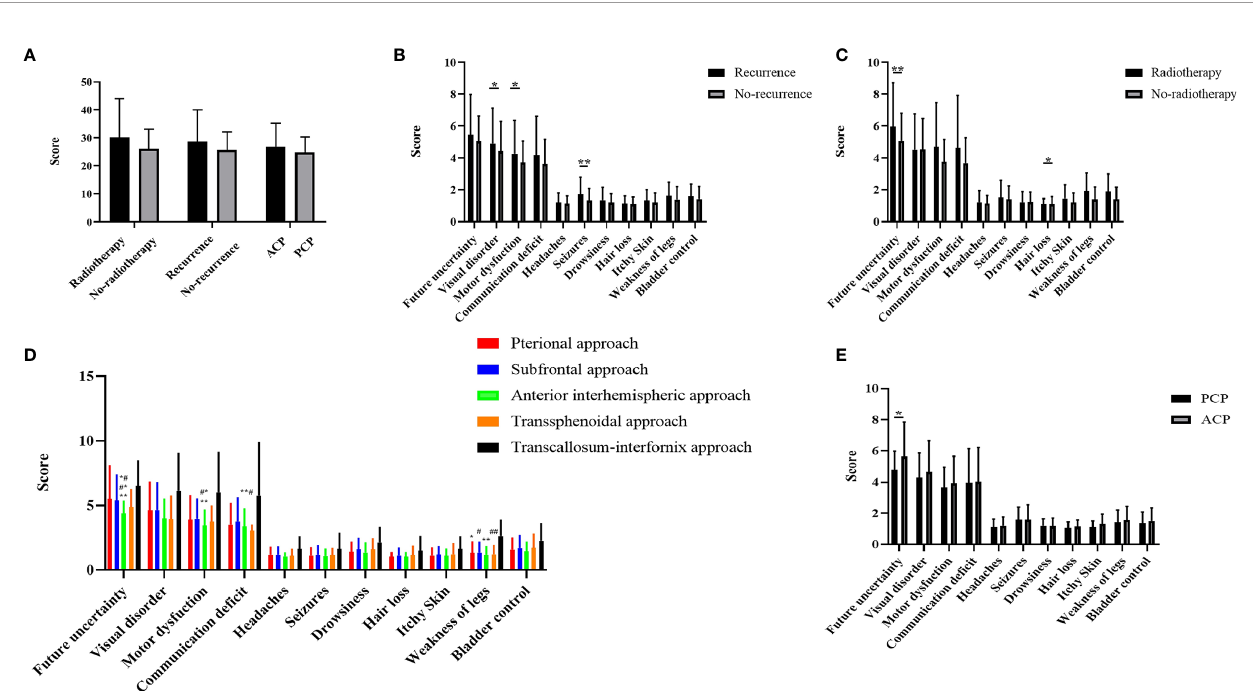
FIGURE 4 | (A) Comparison of three groups of variables on the total BN20 score (Mann-Whitney U test, *p < 0.05, **p < 0.01). (B) Comparison of craniopharyngioma patient life quality between recurrence and non-recurrence groups (Mann-Whitney U test, *p < 0.05, **p < 0.01). (C) Comparison of craniopharyngioma patient life quality between radiotherapy and non-radiotherapy groups (Mann-Whitney U test, *p < 0.05, **p < 0.01). (D) Comparison of craniopharyngioma patient life quality between fi ve different approaches (Kruskal Wallis test with post hoc Bonferroni correction, p < 0.01, *represent pterional approach vs . TI approach, **represent AI approach vs . TI approach, # represent subfrontal approach vs . TI approach, ## represent transsphenoidal approach vs. TI approach, *# represent pterional approach vs AI approach, #* represent subfrontal approach vs AI approach, **# represent subfrontal approach vs transsphenoidal approach). (E) Comparison of craniopharyngioma patient life quality between PCP and ACP groups (Mann-Whitney U test, *p < 0.05).